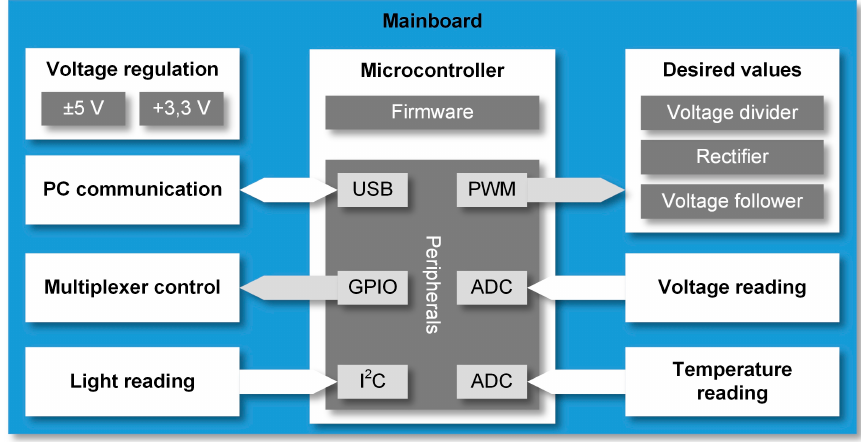
Figure 3. Block diagram of the mainboard.